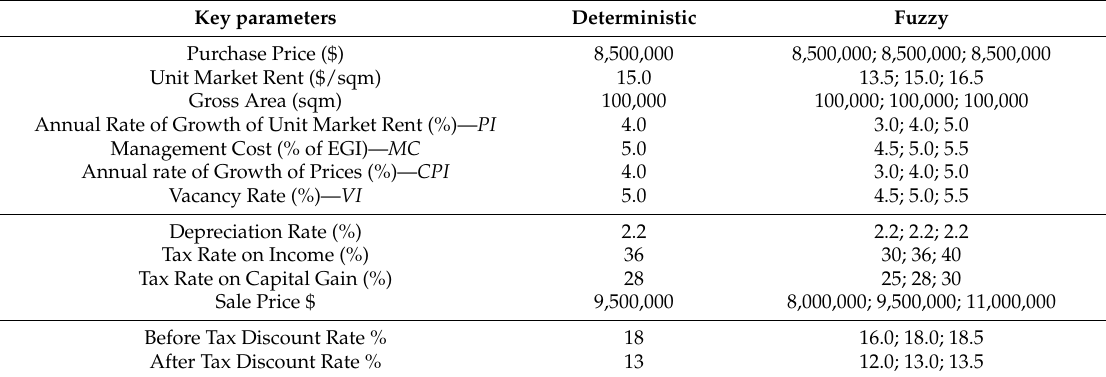
Table 1. Assumptions concerning key parameters involved in the analysis of investment projects. Key parameters